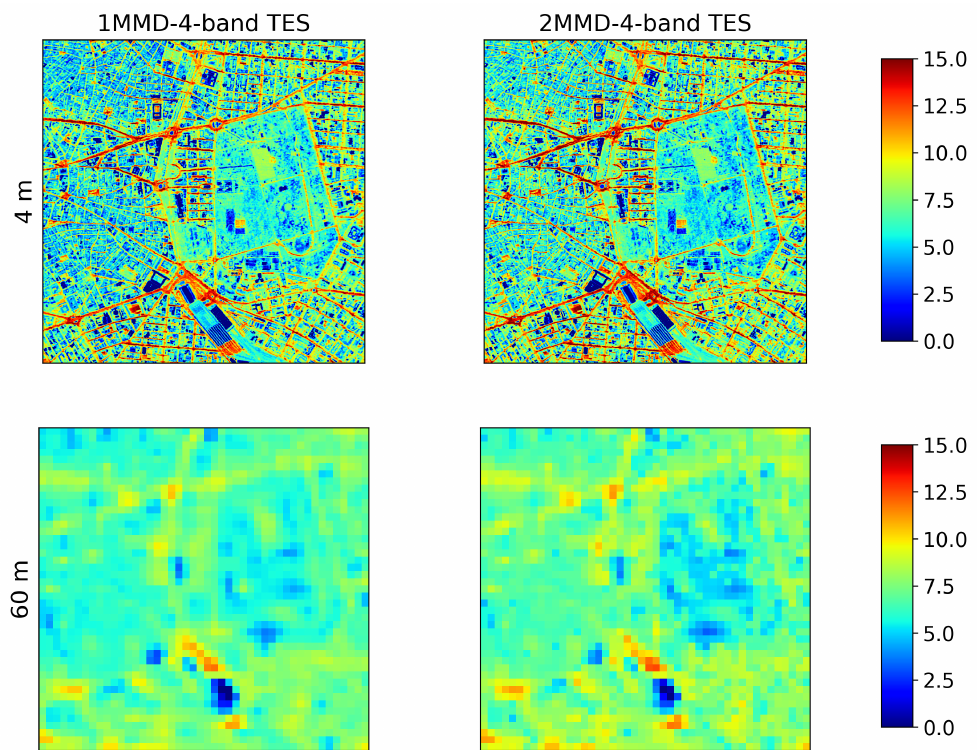
Figure 18. SUHI in K retrieved over the Retiro Park with the 1MMD-4-band TES ( left ) and the 2MMD-4-band TES ( right ) at a 4-m spatial resolution ( top ), at a 60-m spatial resolution ( bottom